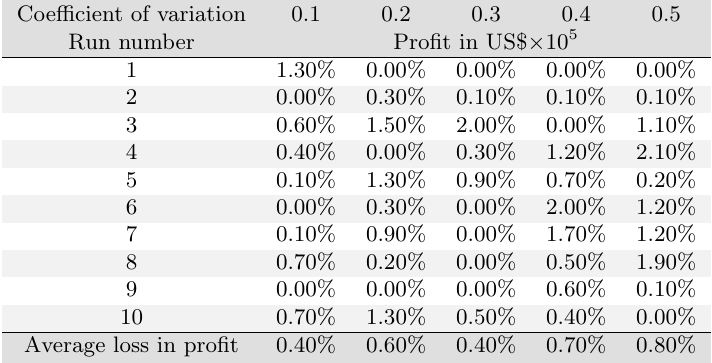
Table 11: Percentage loss in profit when using a fixed trawler schedule as opposed to a variable trawler